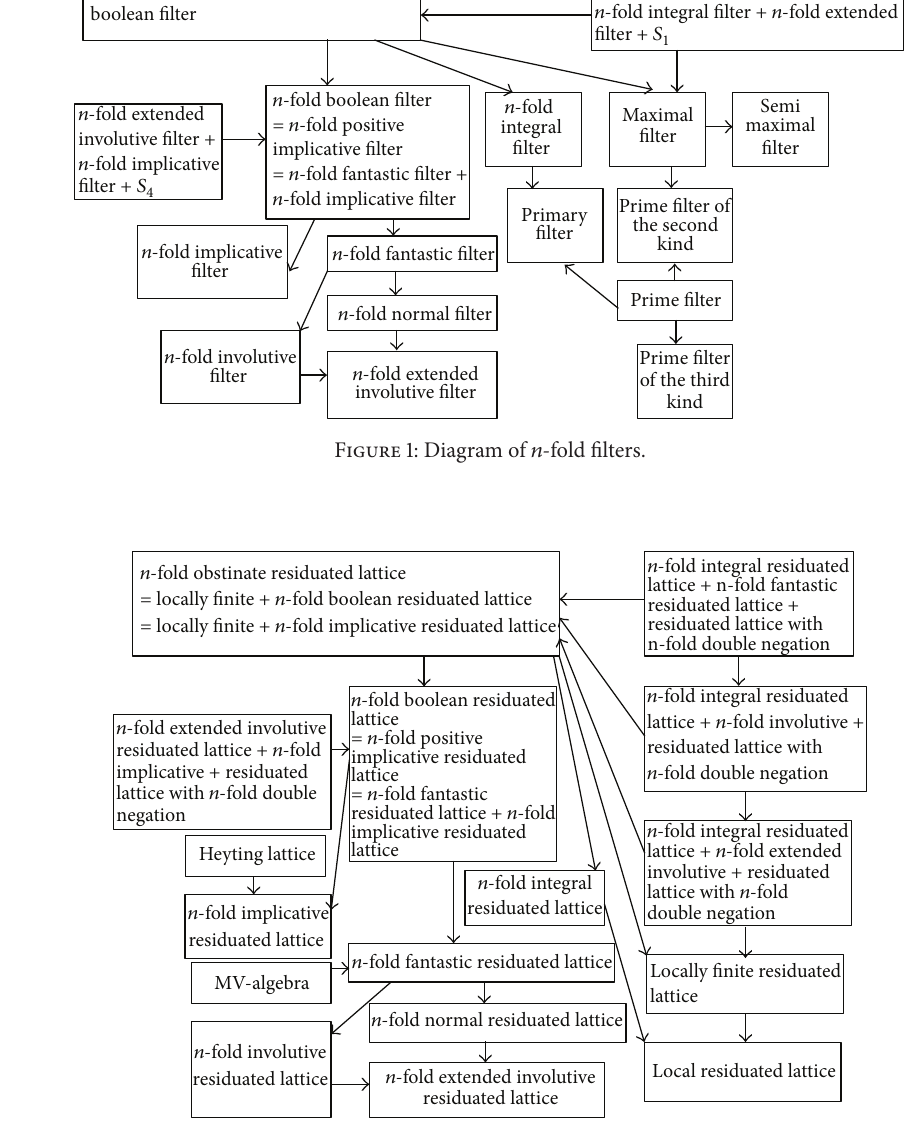
Figure 2: Diagrams of 𝑛 -fold residuated